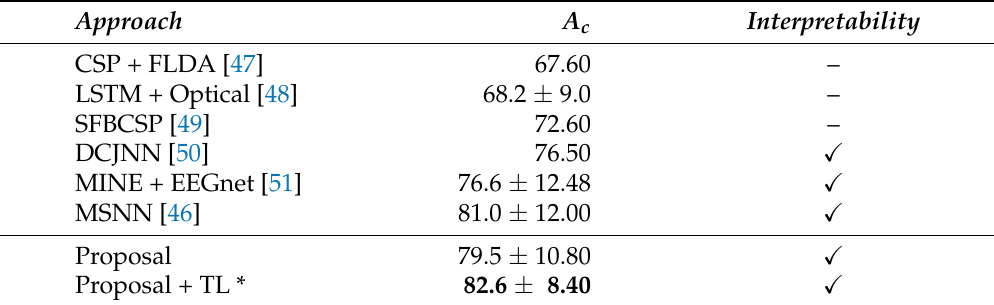
Table 2. Comparison of bi-class accuracy achieved by state-of-the-art approaches in GigaScience . The best value is marked in bold. Notation * denotes Deep and Wide framework results with transfer learning (TL). CSP + FLDA: Common spatial patterns and Fisher linear discriminant analysis, LSTM + Optical: Long-short term memory network and optical predictor, SFCSP: Sparse filter-bank CSP, DCJNN: Deep CSP neural network with joint distribution adaptation, MINE+EEGnet: Mutual information neural estimation, MSNN: Multi-scale Neural Network.